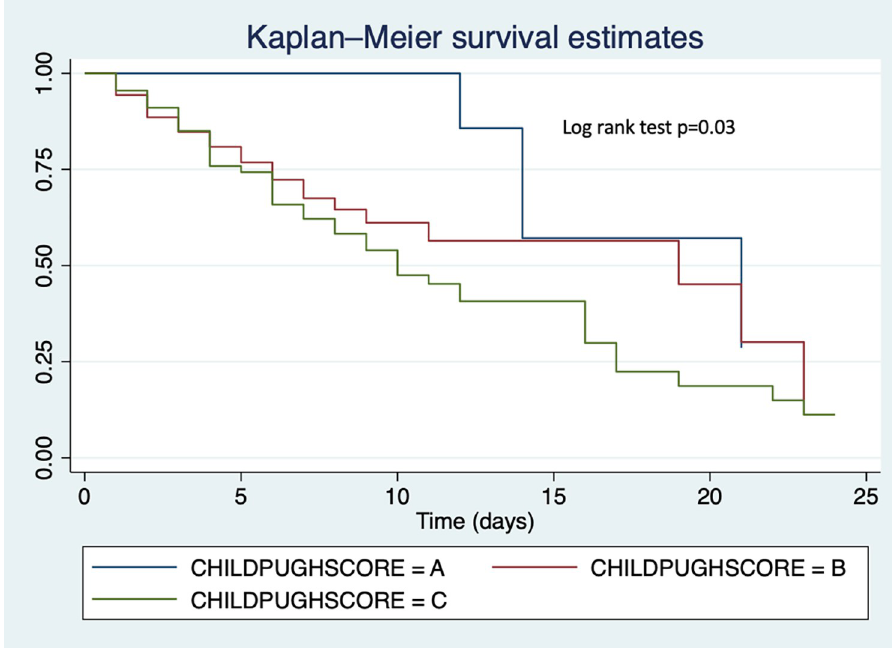
Fig 6. Kaplan-Meier survival curves comparing in-patient survival by Child-Pugh